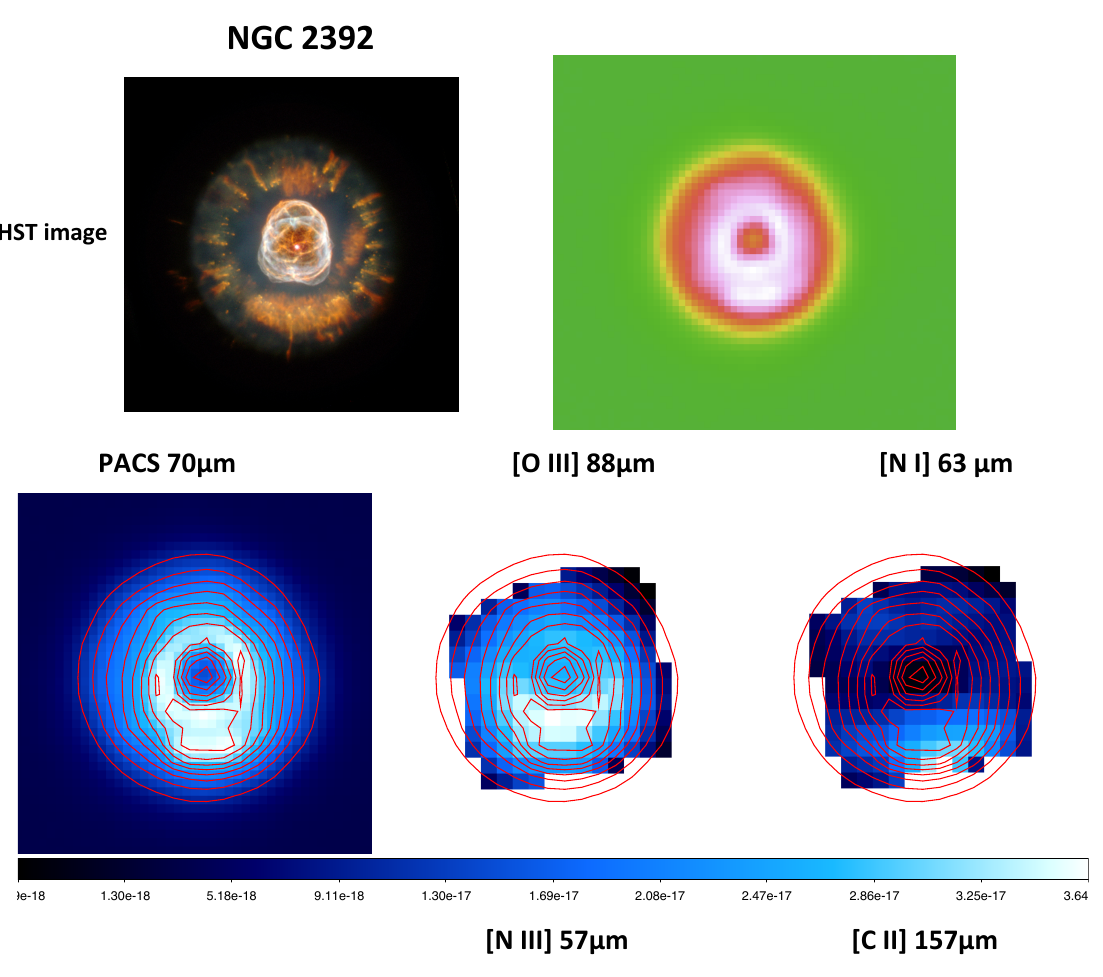
Figure 1. Images of selected PNe of the HerPlaNs programme. In all figures, the top shows an optical image for comparison to the PACS IR image at 70 µ m, these being approximately similarly scaled (N up, E left). The IR image is shown again on the bottom with contours to help the eye pick out the shape. These contours are then overplotted on two spectral images, which were chosen to demonstrate the morphology of the nebula in the indicated ions. The mapped ion identifications are printed above the spectral images, and those ions with a similar appearance are printed below. NGC 2392. ( Top ) An optical image (HST, WFPC2) and the PACS 70 µ m image. ( Bottom ) The PACS photometer image and two spectral